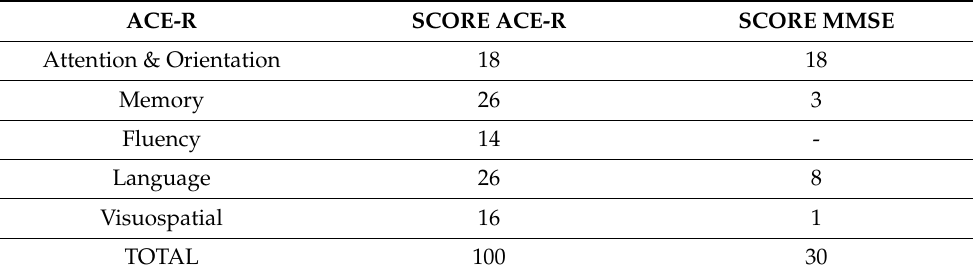
Table 2. ACE-R and MMSE point